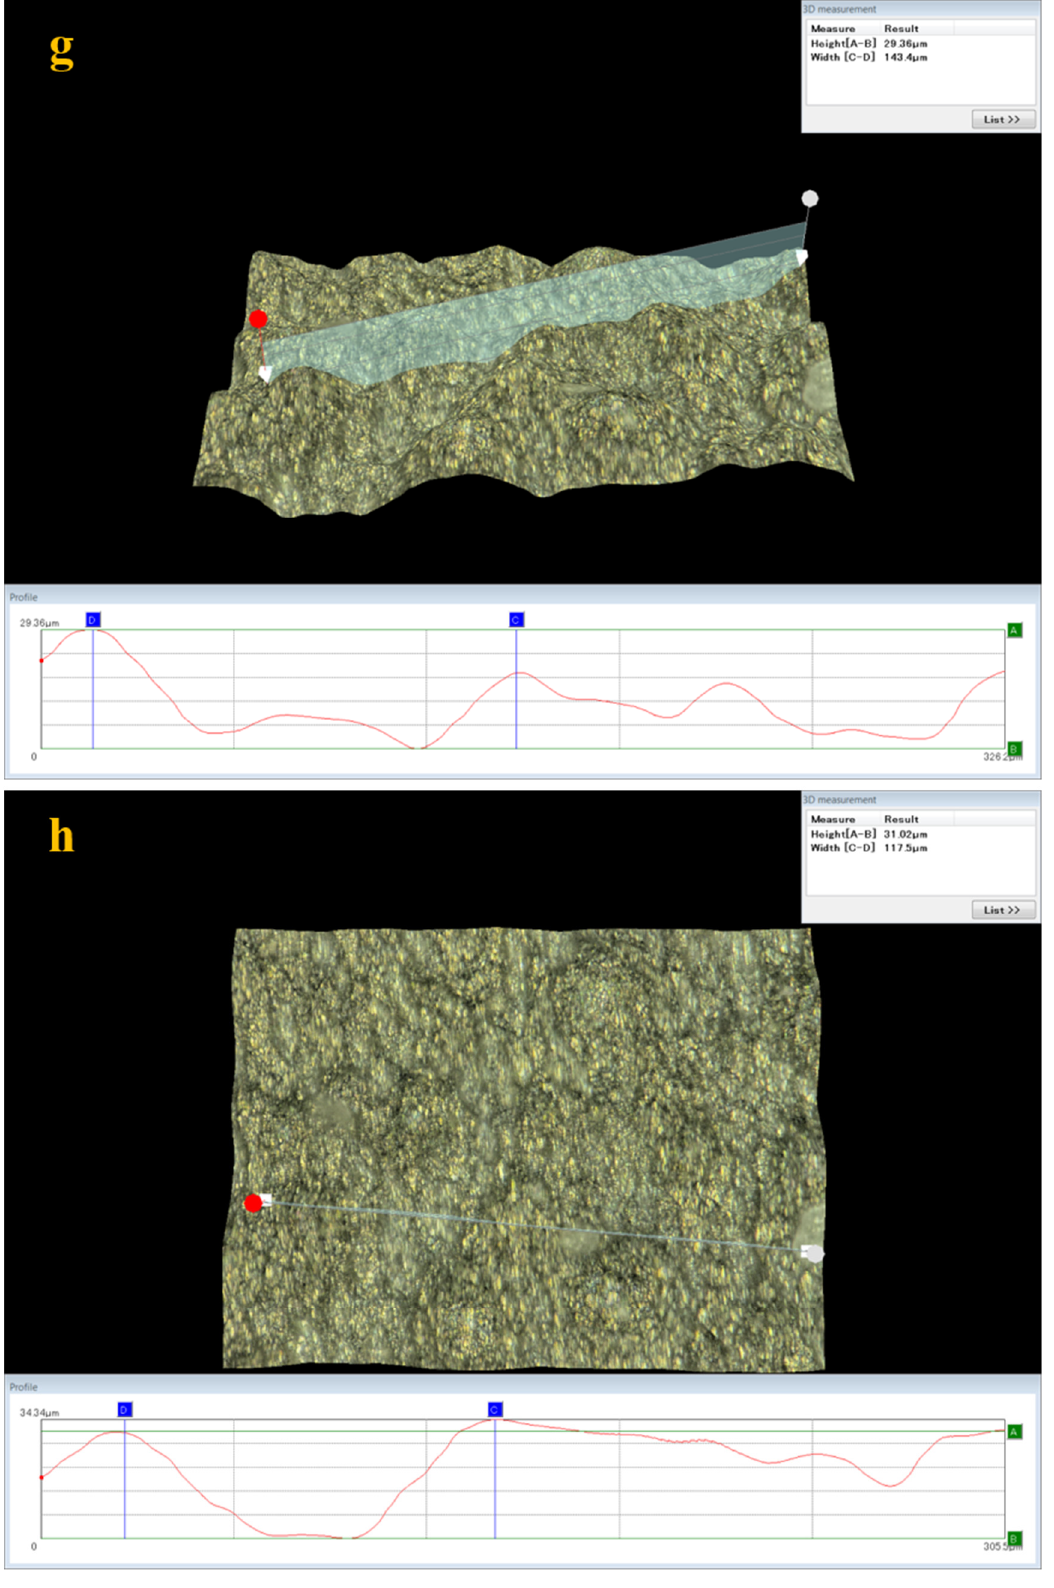
Figure 19. Sizes of pits: ( a , b ) C110-1 in gas; ( c , d ) C110-1 in liquid; ( e , f ) C110-2 in gas; ( g , h ) C110-2 in liquid.